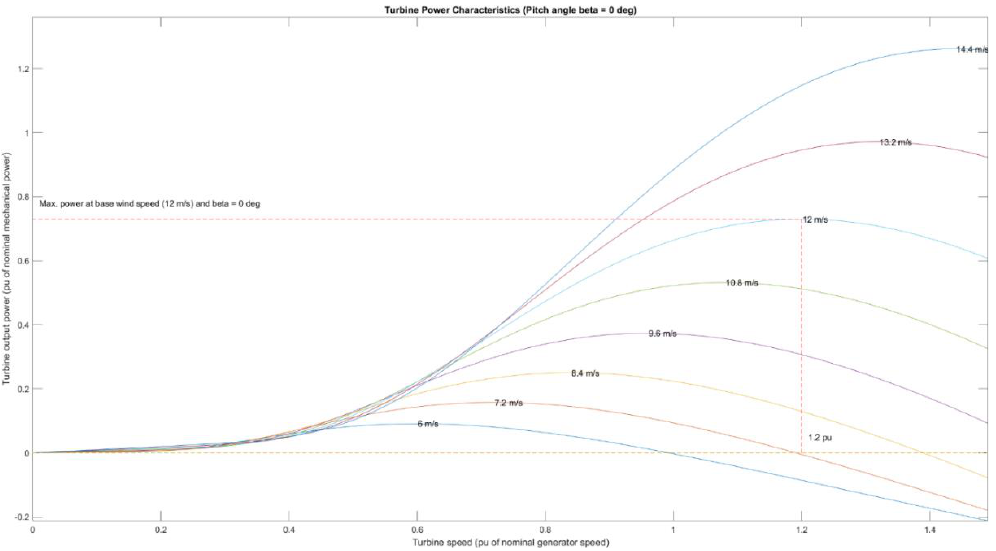
Figure 14. Selected turbine power simulation in different wind speeds.